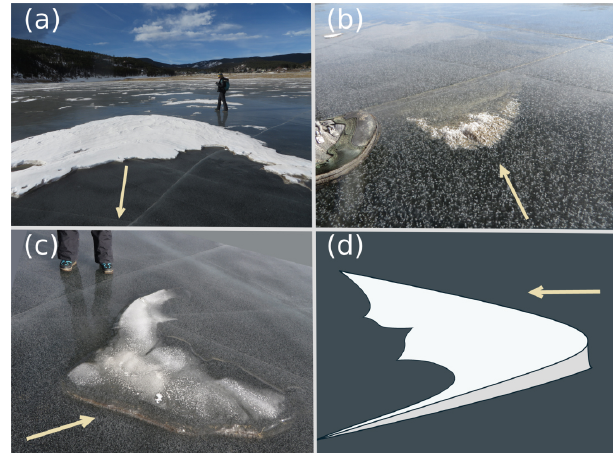
Figure 10. Stealth dunes viewed from several angles on Barker Reservoir, Colorado, on 16 January 2016. (a) Large stealth dune. (b) Remnant of small stealth dune. (c) Marks left on ice beneath a dune; surface is raised by 1.5cm. (d) Schematic of stealth